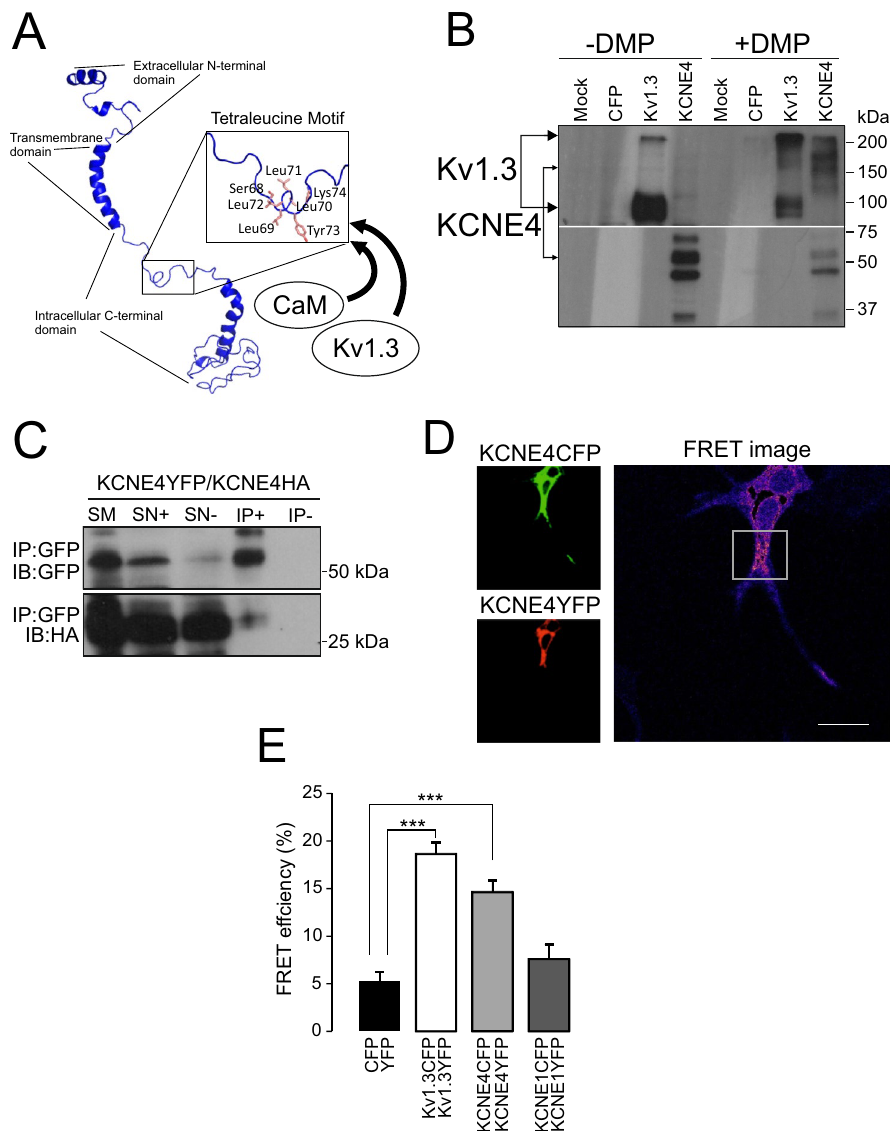
Figure 3. KCNE4 homo-oligomerization. HEK-293 cells were transfected with different KCNE4-tagged peptides, and their homo-oligomeric formation ability was studied. ( A ) Molecular simulation of KCNE4 using the KCNE1 template (PDB code 2K21) as described in the Materials and Methods. The inset highlights the tetraleucine signature (L69-72A) where CaM and Kv1.3 associate. ( B) Oligomerization of KCNE4. Cell lysates were incubated in the absence ( −) or presence ( +) of DMP (dimethyl pimelimidate). Filters were immunobloted against CFP (Kv1.3-CFP, KCNE4-CFP). Lower Kv1.3 arrow, Kv1.3 monomers. Upper Kv1.3 arrow, Kv1.3 tetramers. Lower KCNE4 arrow, KCNE4 monomers. Upper KCNE4 arrow, KCNE4 oligomers. Mock- and CFP-transfected cells were used as negative controls. ( C ) HEK-293 cells were cotransfected with KCNE4-YFP and KCNE4-HA. Immunoprecipitation was performed for KCNE4-YFP (IP: GFP). Top panel: Immunoblot (IB) against GFP. Bottom panel: immunoblot (IB) against HA. SM: starting material. SN + , supernatant in the presence of antibody. SN-, supernatant in the absence of antibody. IP + , Immunoprecipitation in the presence of the anti-GFP antibody. IP- Immunoprecipitation in the absence of the anti-GFP antibody. ( D , E ) HEK-293 cells were transfected with Kv1.3-, KCNE1- and KCNE4-tagged (CFP/YFP) proteins. Homo-oligomerization of Kv1.3 and KCNE4, but not KCNE1, as analyzed by the FRET acceptor-photobleaching technique. ( D ) Green, representative image of a KCNE4-CFP donor. Red, representative image of a KCNE4-YFP acceptor. FRET image, white square highlights a ROI showing FRET image obtained after photobleaching. Bars represent 10 μm. ( E ) Quantification of the FRET efficiency (%). CFP/YFP, negative control; Kv1.3CFP/Kv1.3YFP, positive control. ***, p < 0.001 vs CFP/YFP (Student’s t -test). The values represent the mean ± SEM of 22 (CFP/YFP), 33 (Kv1.3CFP/Kv1.3YFP), 28 (KCNE4CFP/KCNE4YFP) and 25 (KCNE1CFP/KCNE1YFP)